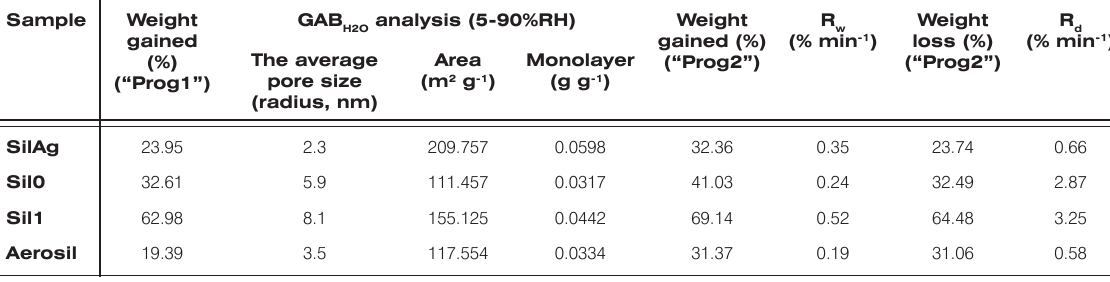
Table 2. Moisture sorption behavior and GAB analysis results for calcined samples and Aerosil.